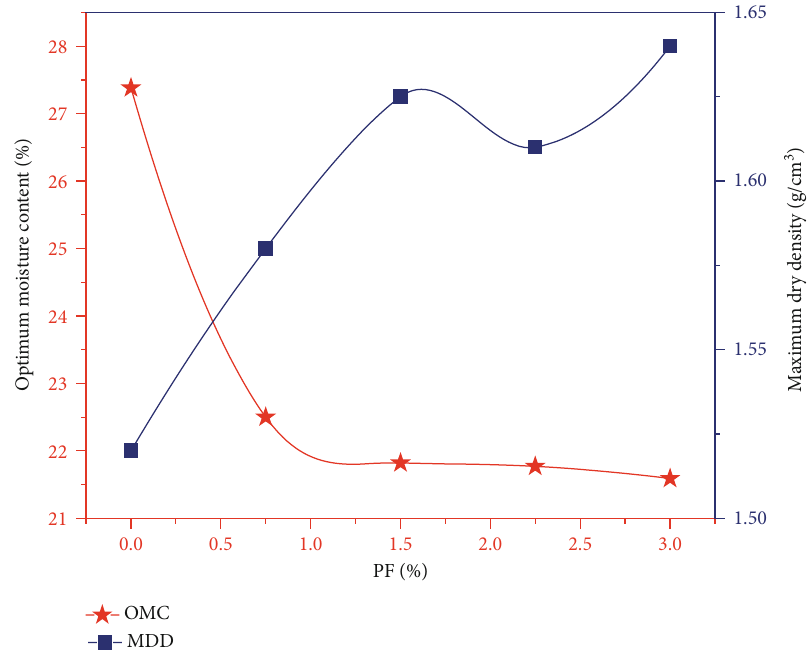
Figure 5: Maximum dry density (MDD) and optimum moisture content (OMC) for unstabilised and PF-stabilised